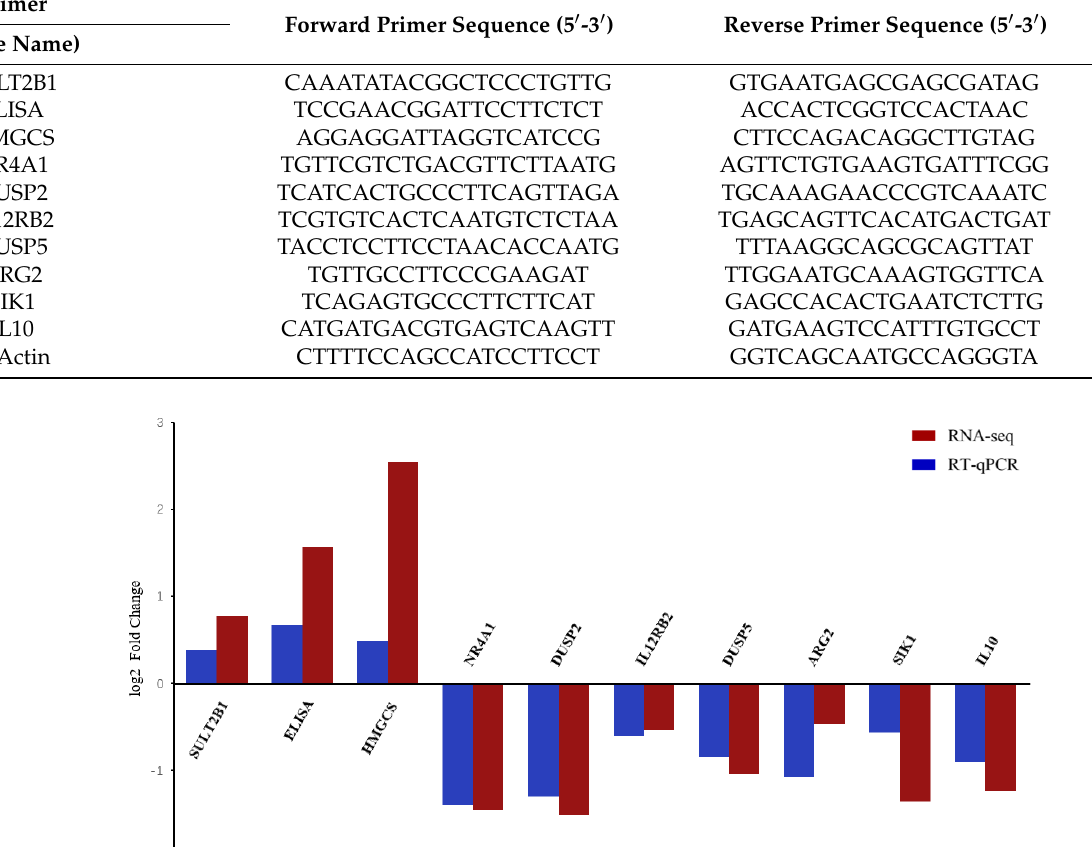
Table 2. Primer sequences for qRT-PCR verification.